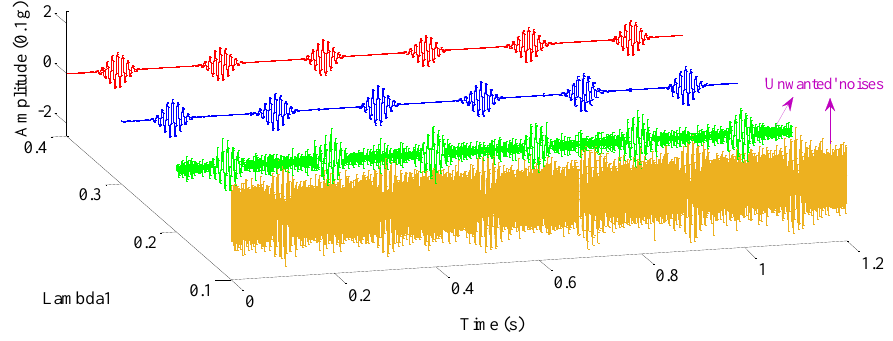
Figure 10. High-resonance components in cases where λ 1 = 0.1,0.2,0.3,0.4.